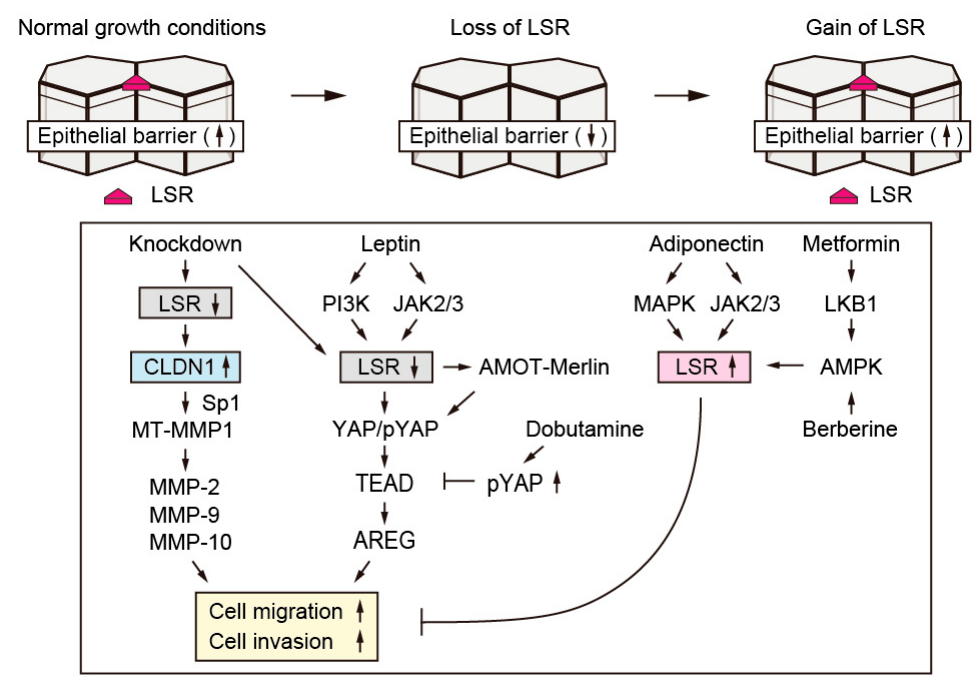
Figure 3. Changes in cellular functions by repression and re-expression of LSR. Under normal growth conditions, LSR localized in tricellular contacts in primary cultured normal human endometrial cells and Sawano cells. The knockdown of LSR enhanced cell motility and cell growth accompanying with decrease in barrier function. Leptin suppressed LSR expression; in contrast, adiponectin induced an increase in its expression. AMPK activator metformin and berberine also induced an increase in LSR expression at the subapical region of tricellular contacts, resulting in the rescue of the LSR-knockdown